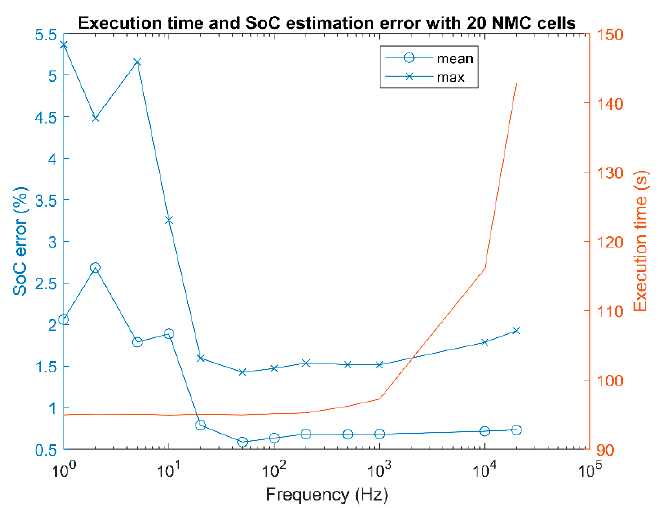
Figure 5. Mean error and maximal error between real and estimated SoC over 100 s of a normalized New European Driving Cycle (NEDC) profile with 20 NMC cells.